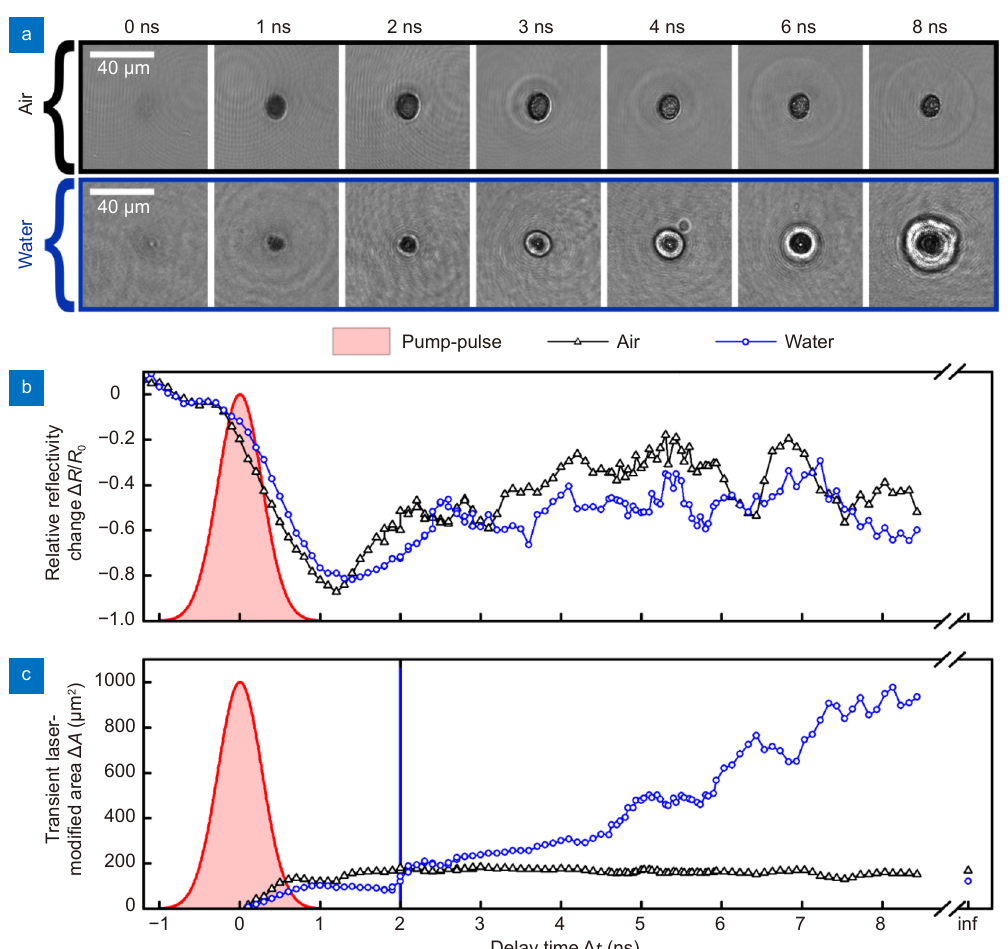
Fig. 3 | ( a ) Exemplary microscopy images at different delay times are displayed . Time-dependent change in ( b ) the relative reflectivity Δ R / R 0 and ( c ) the transient laser-modified area Δ A of the Au target surface for PPM in air (black open symbols) and water (blue open symbols) after irradi- ation with 650 ps pulses at 8 J/cm². The final laser-modified areas Δ A inf are depicted at the Δ t labeled “inf” and the pump-pulses are indicated by red areas. The blue solid vertical line marks the characteristic Δ t where Δ A exceeds its final state value Δ A inf